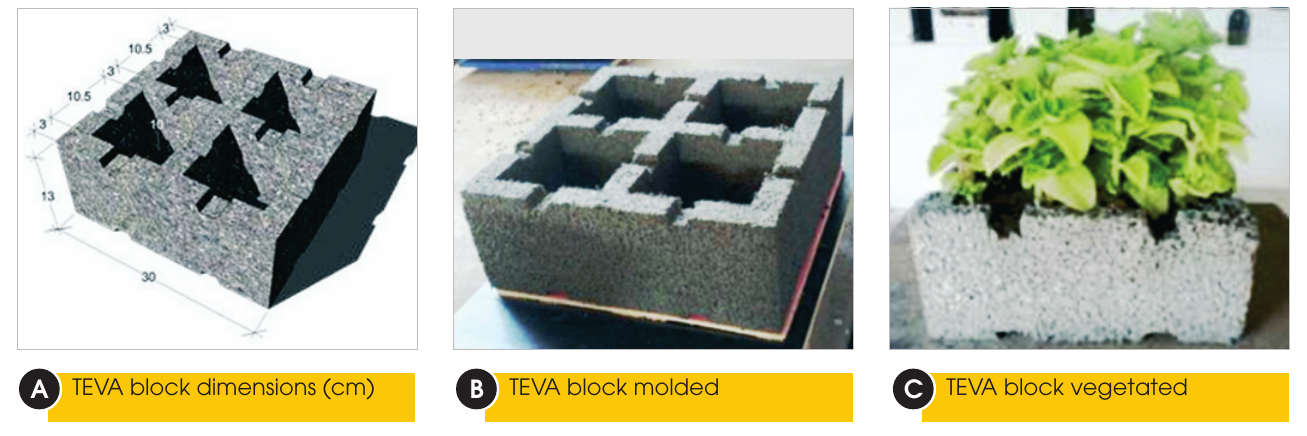
Proposed TEVA block to execute the extensive modular green roof